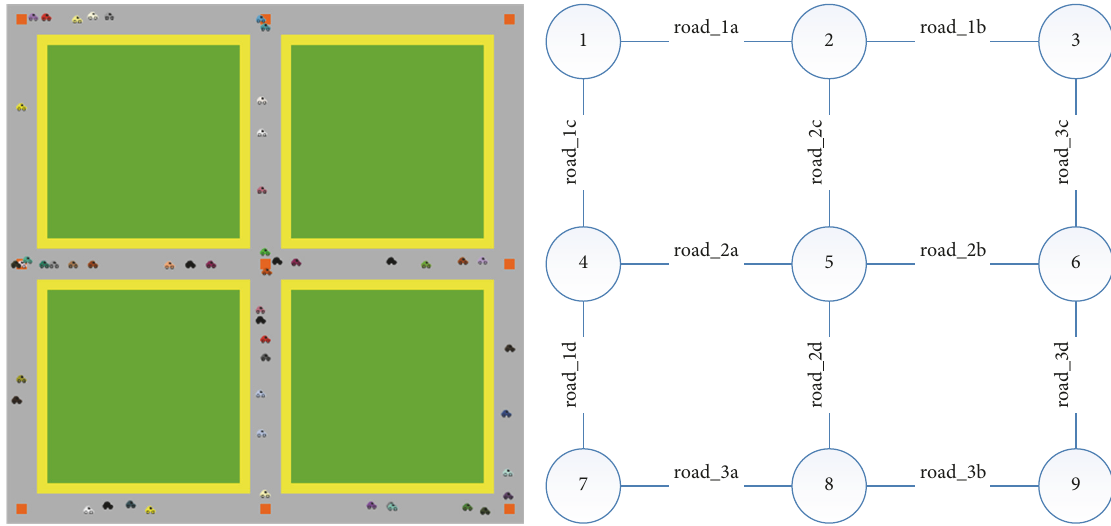
Figure 4: Road network in the simulation environment.